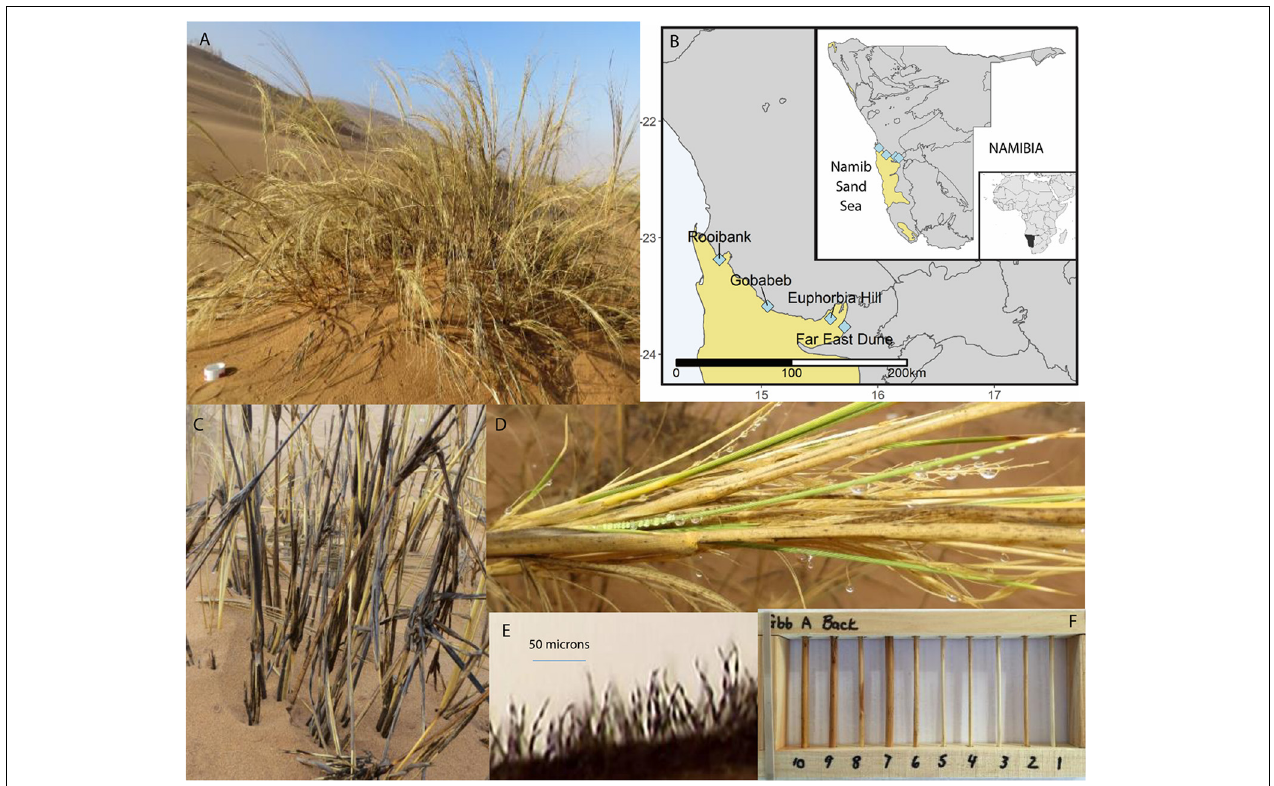
FIGURE 1 | Overview of Stipagrostis sabulicola in the Namib Sand Sea (NSS) context. (A) S. sabulicola in the NSS. Scale is 10 cm diameter PVC pipe in the foreground. (B) Endophyte sampling sites spanning the width of the NSS. Maps created using public domain shapefiles accessed through the Natural Earth database (https://www.naturalearthdata.com/) and the Digital Atlas of Namibia (http://www.uni-koeln.de/sfb389/e/e1/download/atlas_namibia/main_ namibia_atlas.html). (C) Standing senescent tillers of S. sabulicola moistened by an 8-h fog are dark gray because of fungal growth in response to these frequent brief moisture pulses. (D) Dew droplets on living tillers and inflorescence. Note gray spots on senesced leaves which are fungal colonies. (E) Sporulating fungal hyphae on tiller surface following exposure to 10 h of 100% humidity. (F) Wooden racks containing 9-cm tiller sections used during the 6-month decomposition experiment at